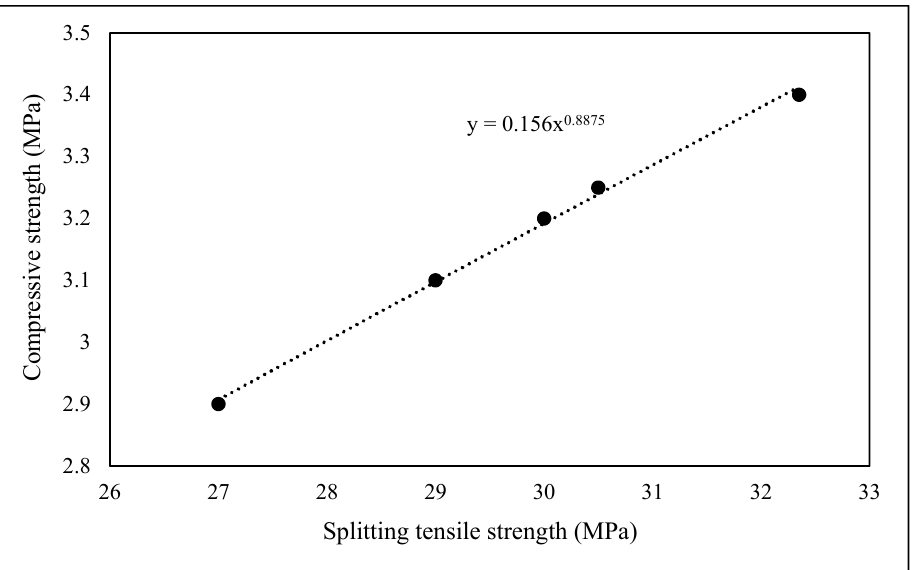
Figure 4. A meaningful correlation between splitting tensile strength and compressive strength, and an equation for estimation of 28th-day compressive strength from splitting tensile strength.